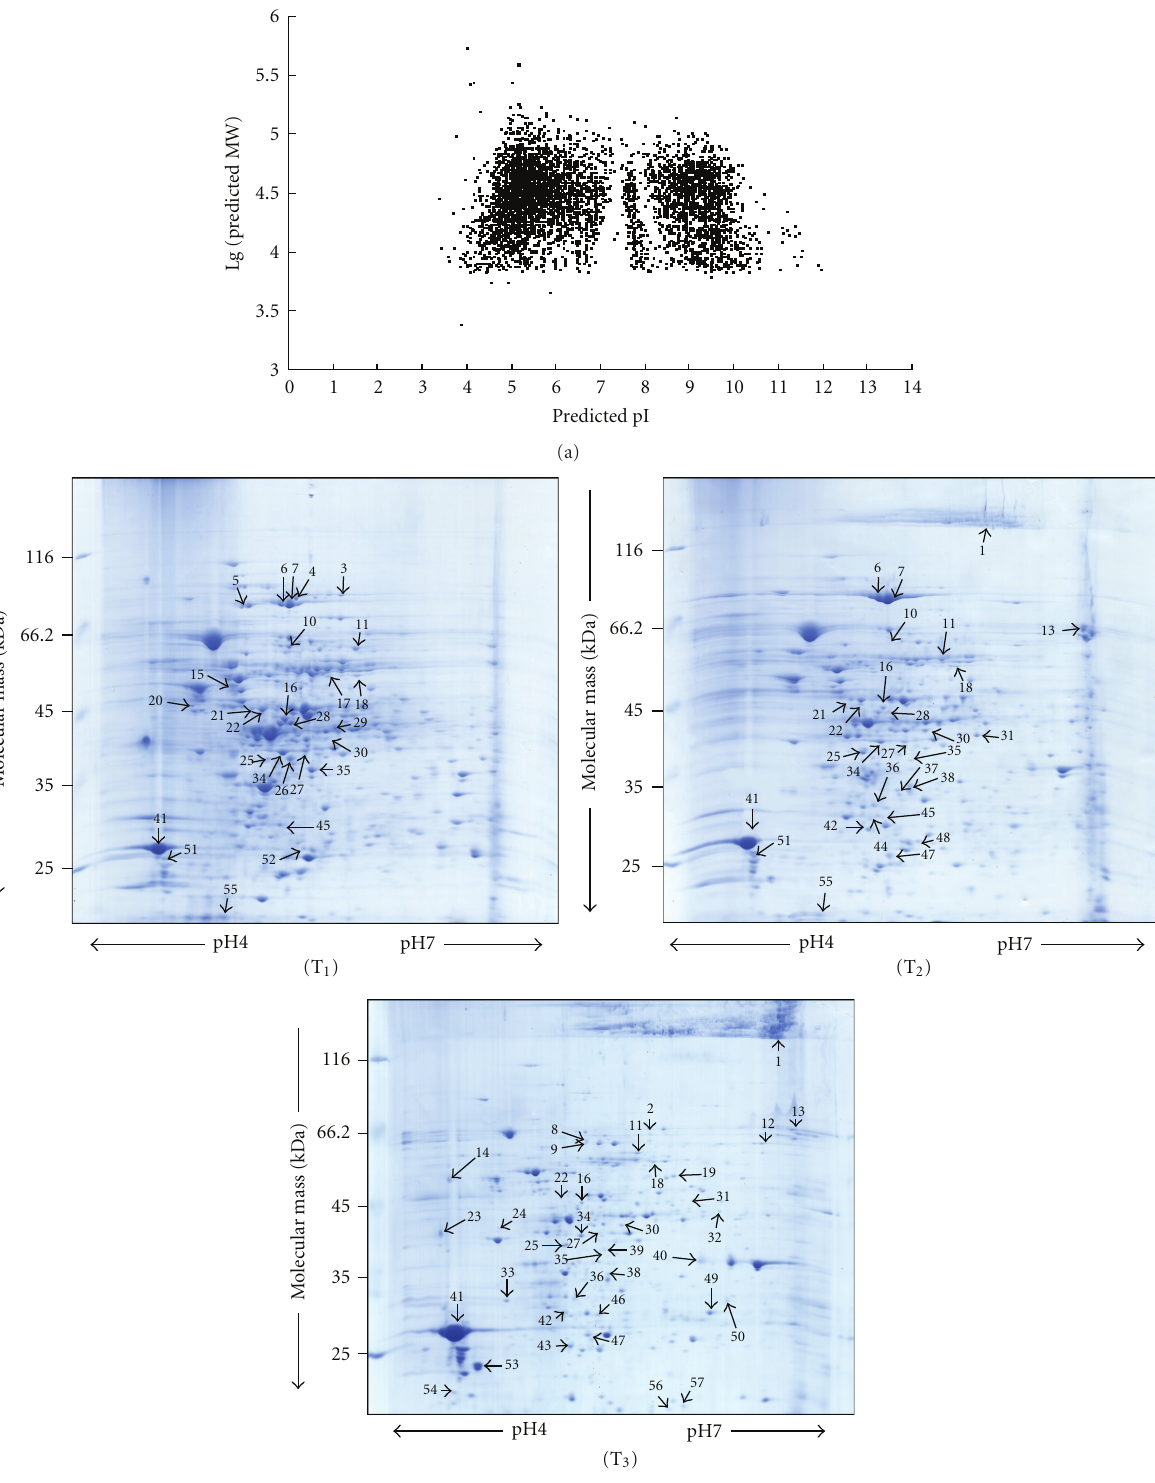
Figure 2: (a) Representation of 2-DE gel separation of the total proteins of whole cell of Bacillus thuringiensis according to predicted pI and molecular masses. (b) 2-DE maps of the proteins of whole cells at T 1 , T 2 , and T 3 from Bt4.0718 strain. The protein spots marked with arrows were identified by MALDI-TOF/TOF